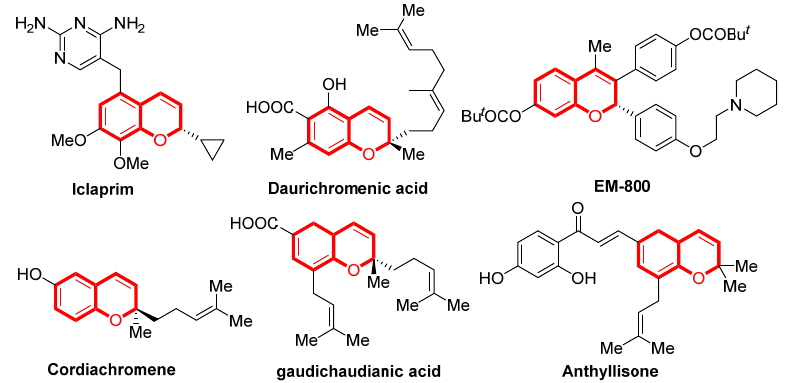
Figure 1. Biologically active 2 ‐ substituted 2 H ‐ chromene